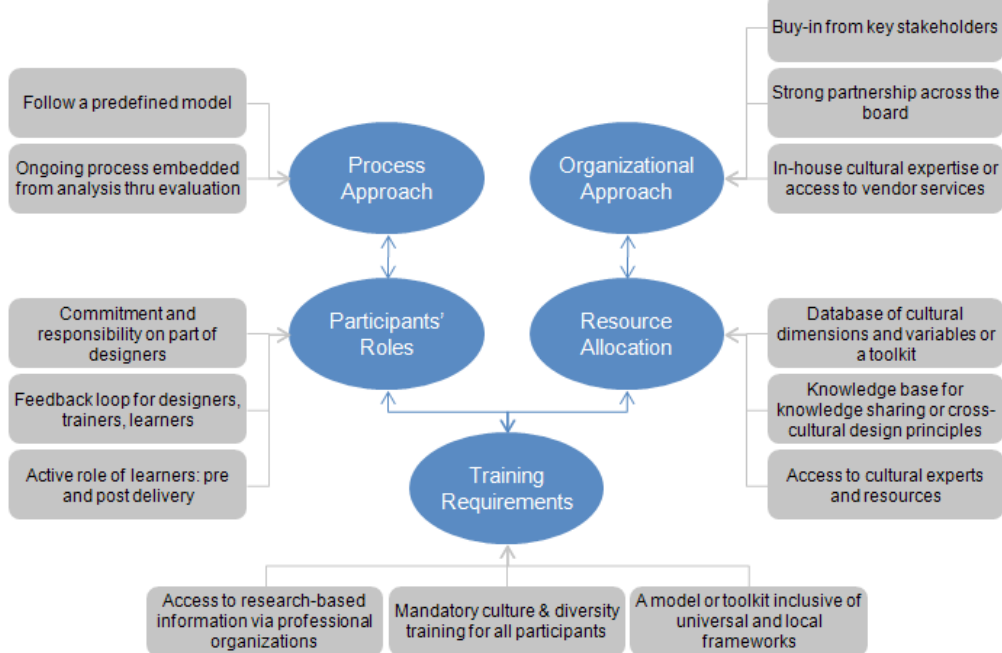
Figure 1. Needs and requirements for cross-cultural learner